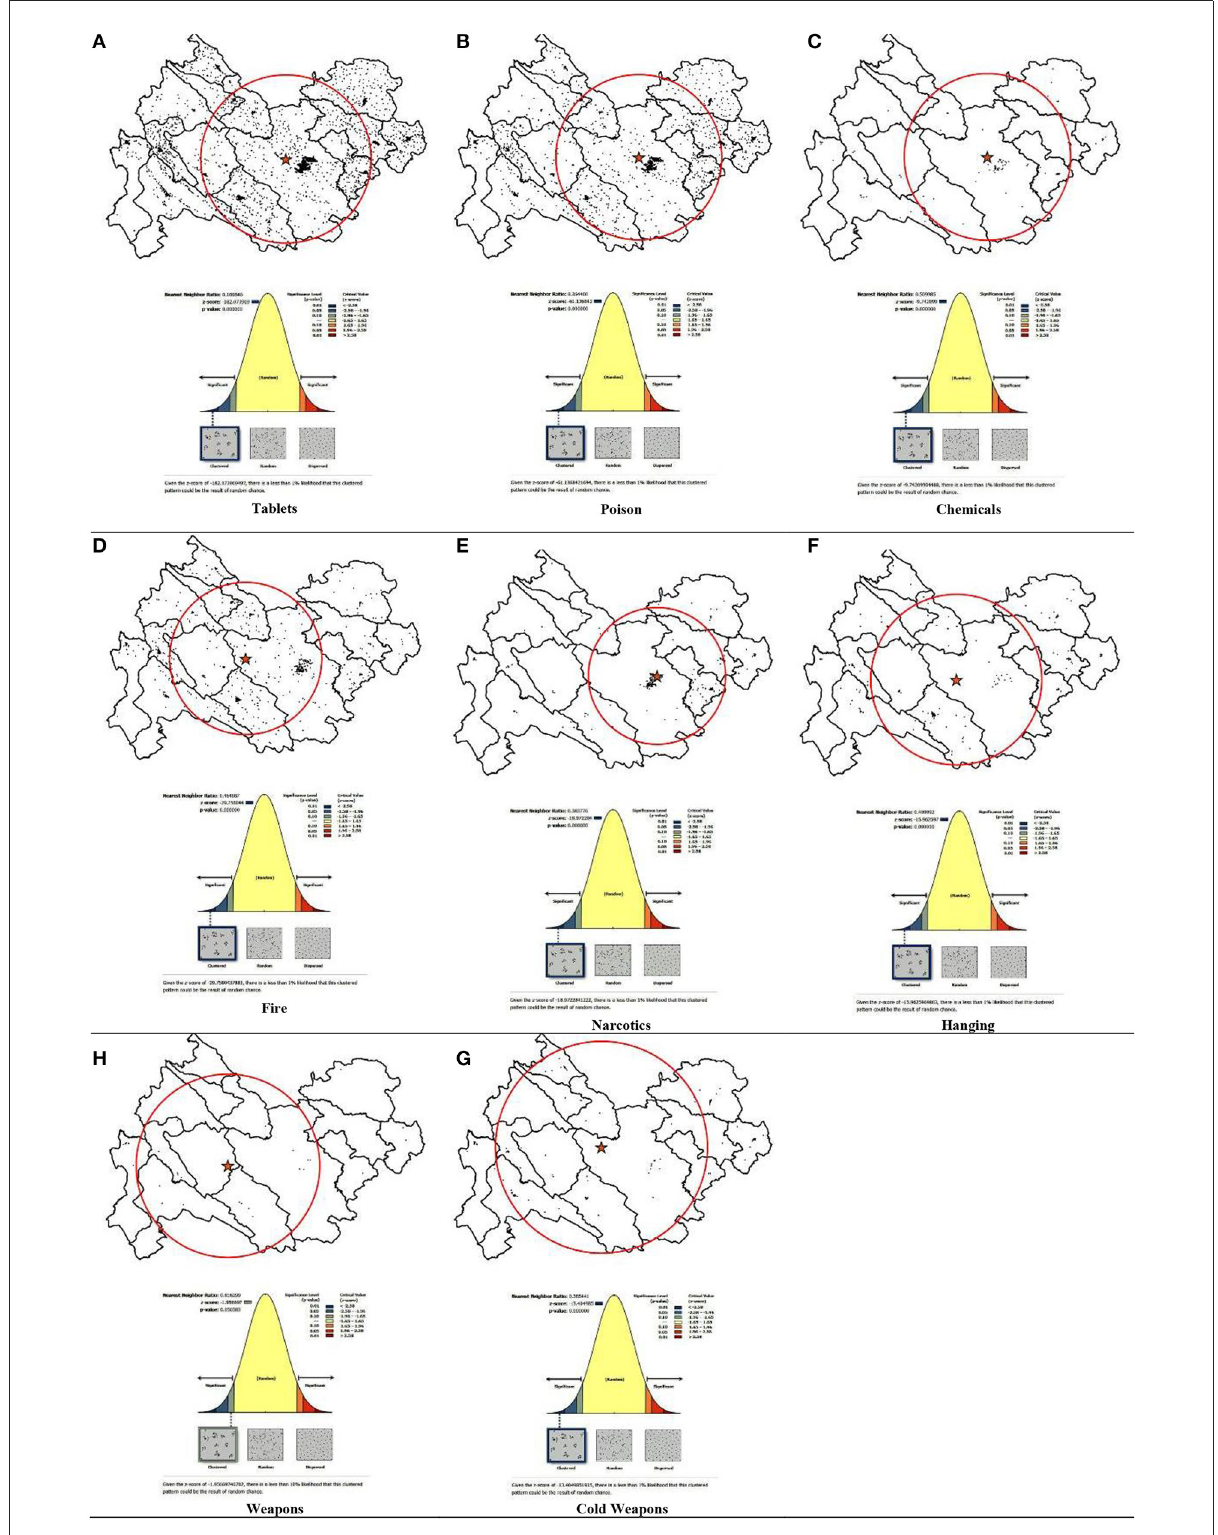
FIGURE1 Geographic distributions (mean center and standard distance) and the analyzing patterns (average nearest neighbor). (A) Tablets, (B) Poison, (C) Chemicals, (D) Fire, (E) Narcotics, (F) Hanging, (G) Weapons, and (H) Cold